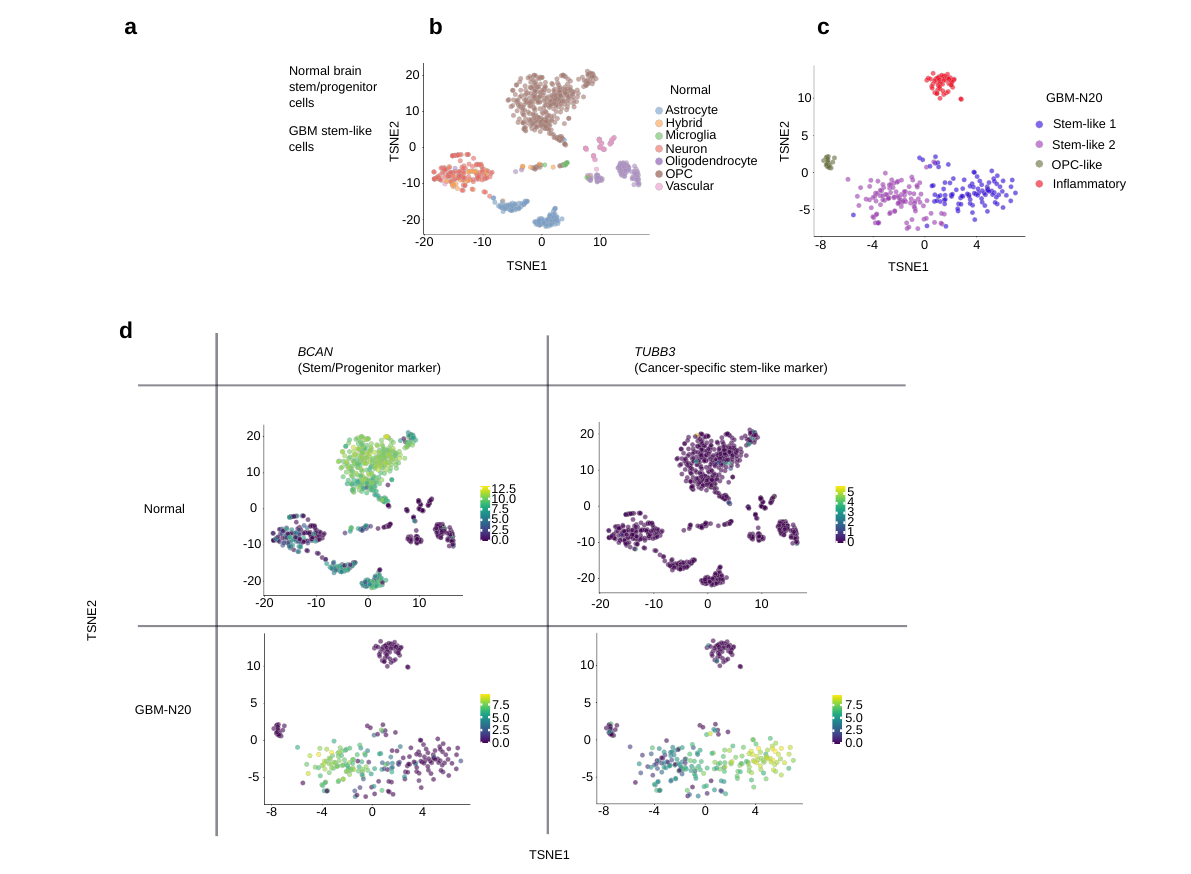
Figure 3. The expression of a general progenitor cell marker and cancer-specific stem-like marker for GBM. ( a ) Both GBM tumors and normal tissue possess progenitor cells. This illustration was created using BioRender.com. ( b ) TSNE for normal brain cells. ( c ) TSNE for the GBM cells from sample N20. ( d ) Comparing the expression of a general progenitor cell marker, BCAN , and a cancer-specific progenitor marker, TUBB3 , between normal brain cells and GBM cells. The color bar with numbers represents the log-normalized counts of the